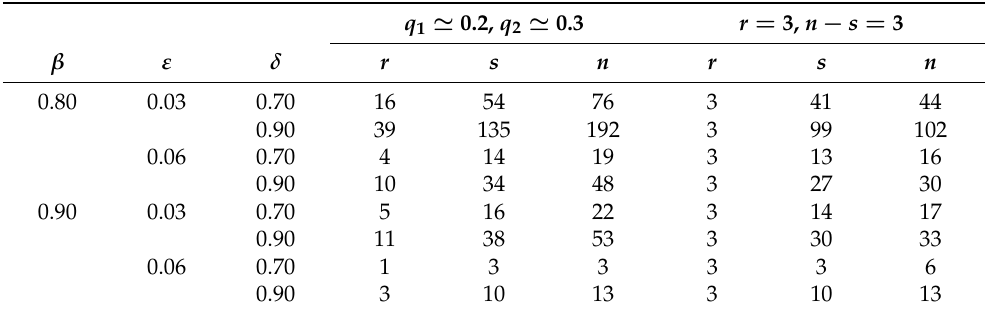
Table 4. Optimal sampling plans ( r , s , n ) for setting lower β -ETLs for the W ( α , θ ) model based on X = ( X r : n ,..., X s : n ) when (i) q 1 (cid:39) 0.2 and q 2 (cid:39) 0.3 and (ii) r − 1 = 2 and n − s = 3.